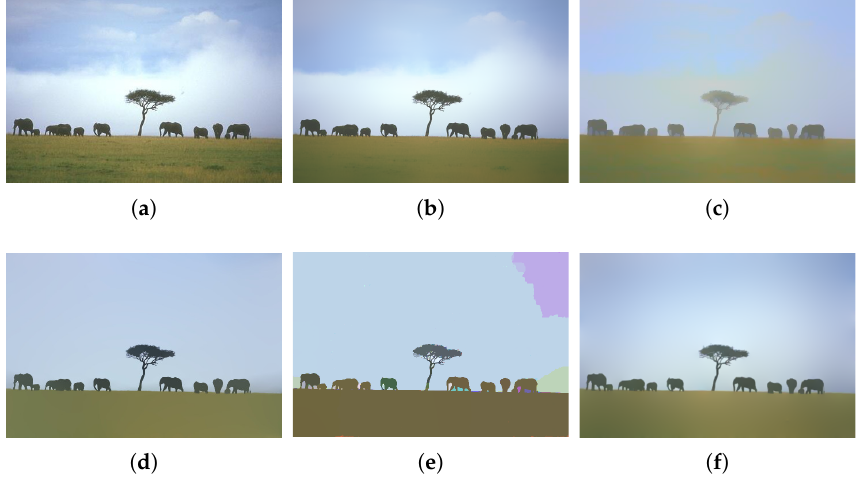
Figure 6. Comparison of our method with other methods in edge extraction. ( a ) Input; ( b ) Bilateral [18] with σ s = 5, σ r = 46; ( c ) WLS [21] with α = 2, λ = 2; ( d ) l 0 -smoothing (http://www.cse.cuhk.edu.hk/ leojia/projects/L0smoothing/EdgeEnhancement.htm) [24]; ( e ) l 0 -projection [29] with α = 9264; ( f ) ours with λ = 10, σ = 0.7.